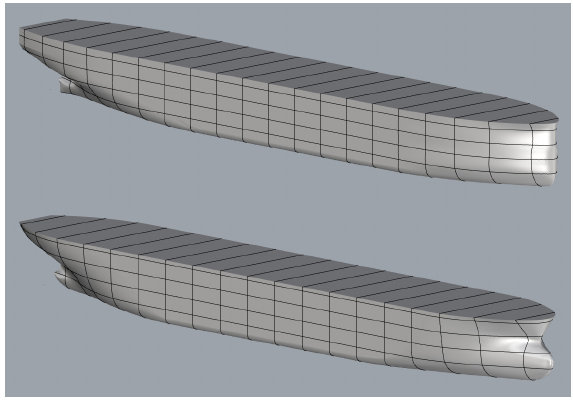
Figure 2. Hull shape - bulk carrier 1 (up), bulk carrier 2 (down)